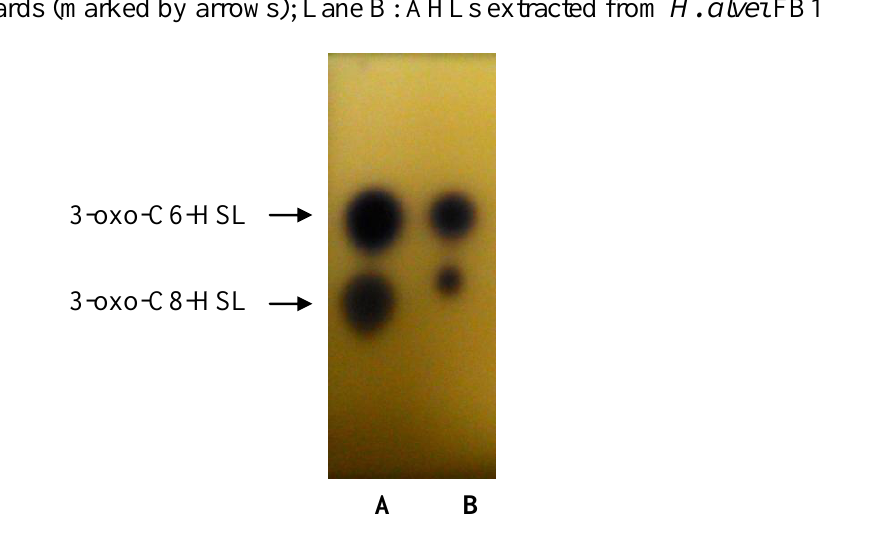
Figure 5. TLC separation of AHLs present in extract of the spent culture supernatant of H. alvei FB1, visualised with agar seeded with C. violaceum CV026 cells. Lana A: Synthetic AHL standards (marked by arrows); Lane B: AHLs extracted from H. alvei